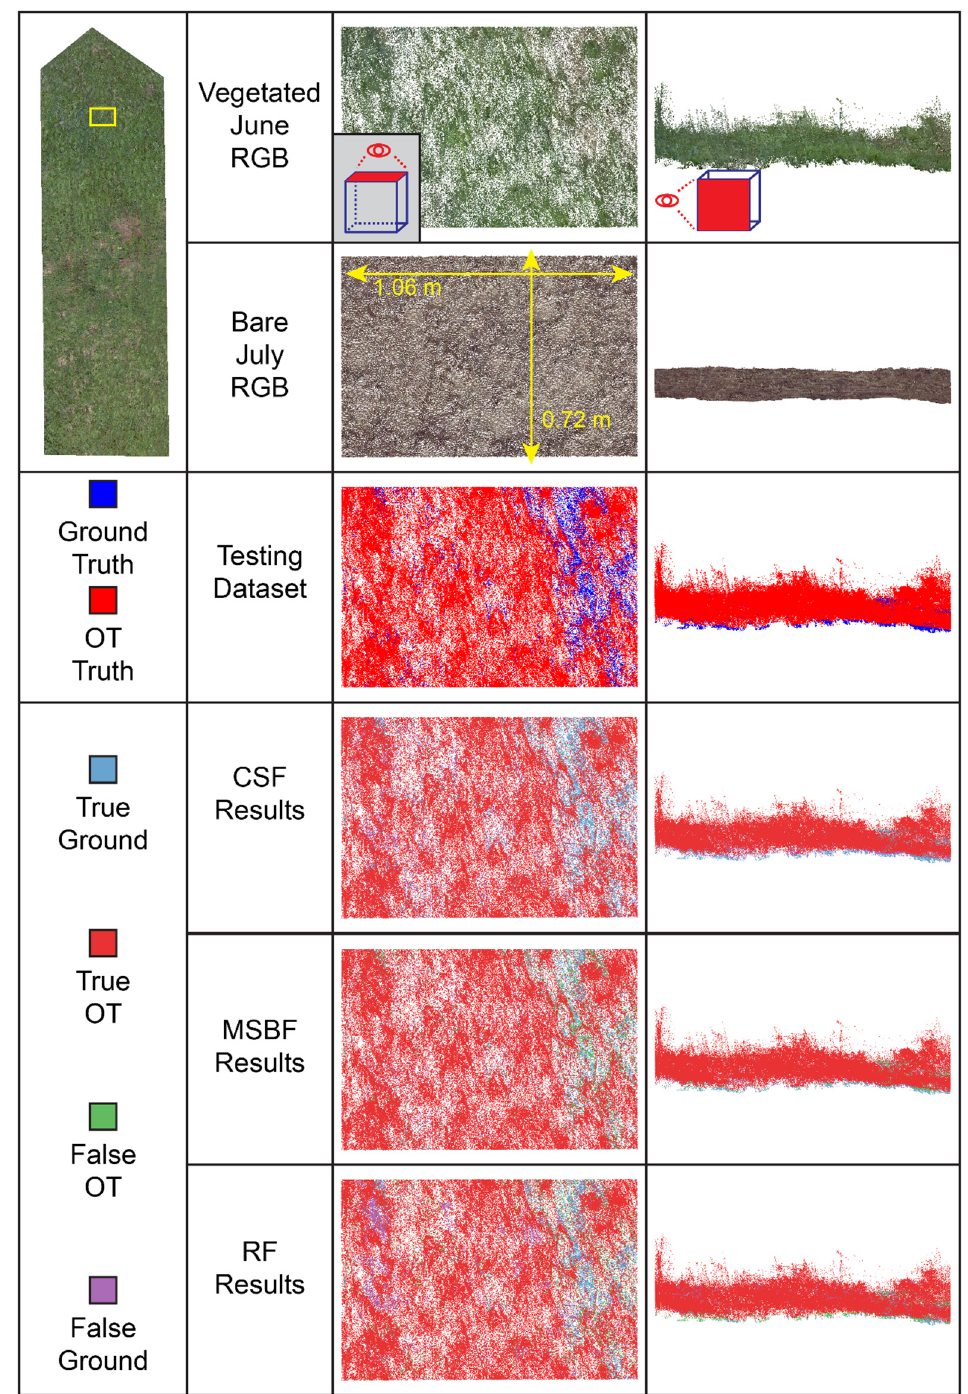
Figure 12. Filtering results on a vegetated portion of the plot.